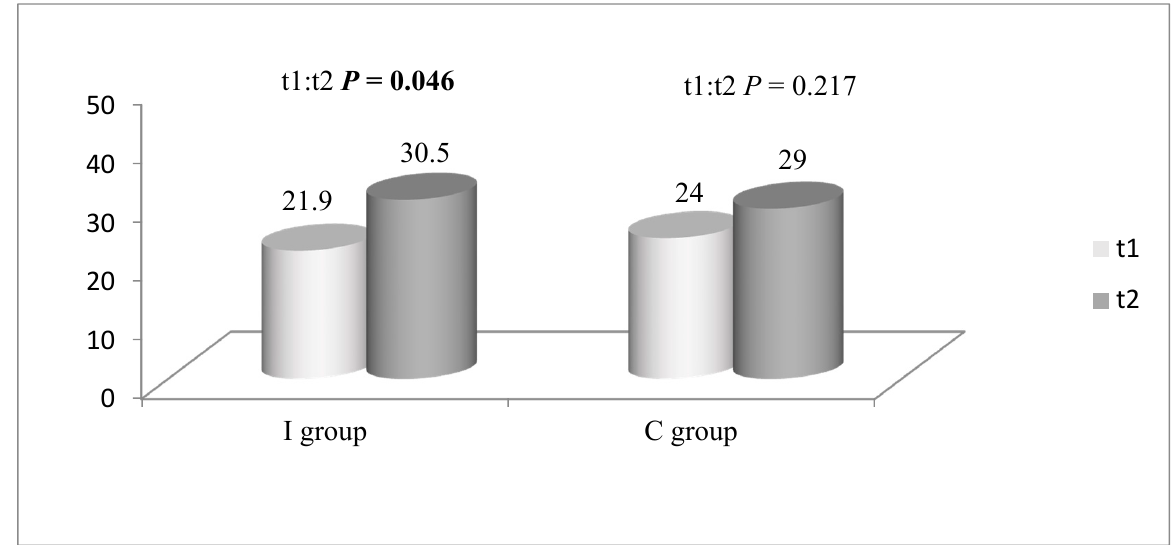
Figure 3. Average time (min.) spent in organized sports activities in the I group and the C group in t1 and t2.